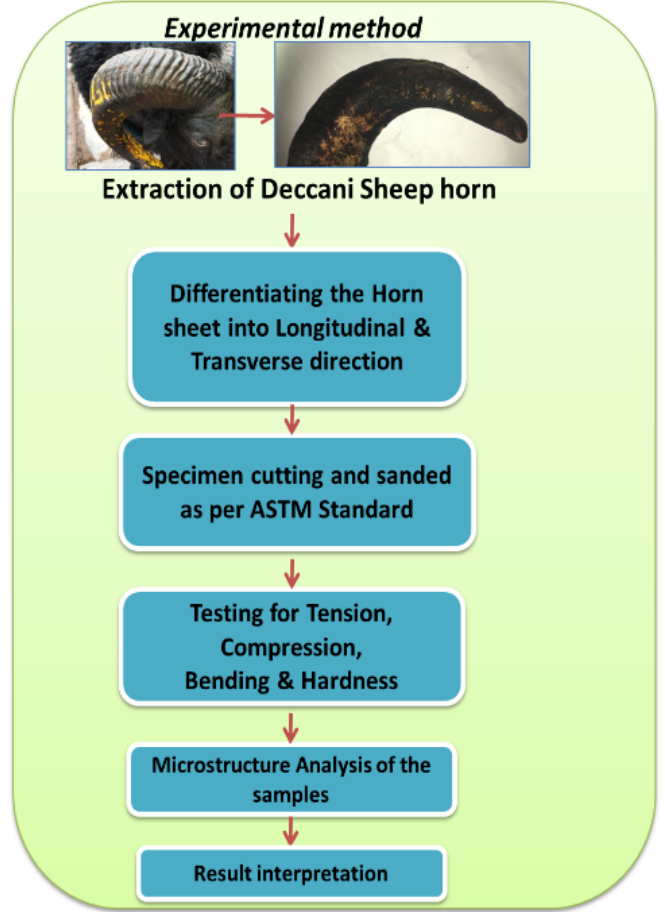
Figure 3. Experimental process methodology.